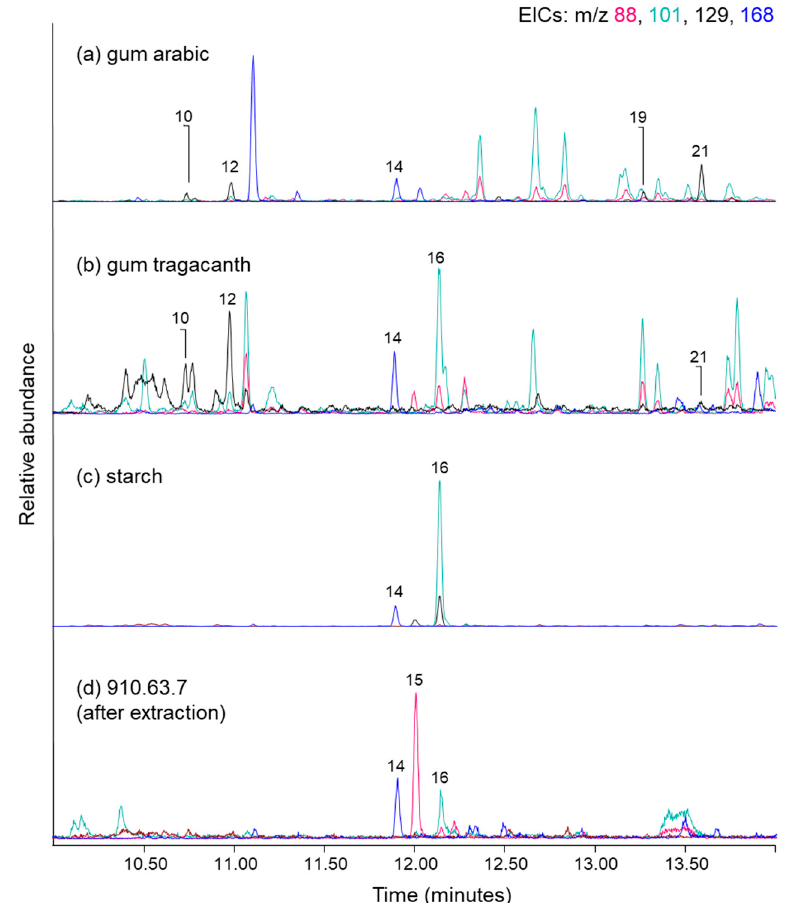
Figure 7. Partial extracted ion chromatograms ( m / z 88, 101, 129, 168) obtained by TMAH Py-GC-MS for hot water extracts of commercial reference materials including ( a ) gum arabic, ( b ) gum tragcanth and ( c ) starch, and ( d ) the ancient cellulosic thread (910.63.7) after it had been subjected to hot water extraction. Peak labels correspond to compounds listed in Table 1.